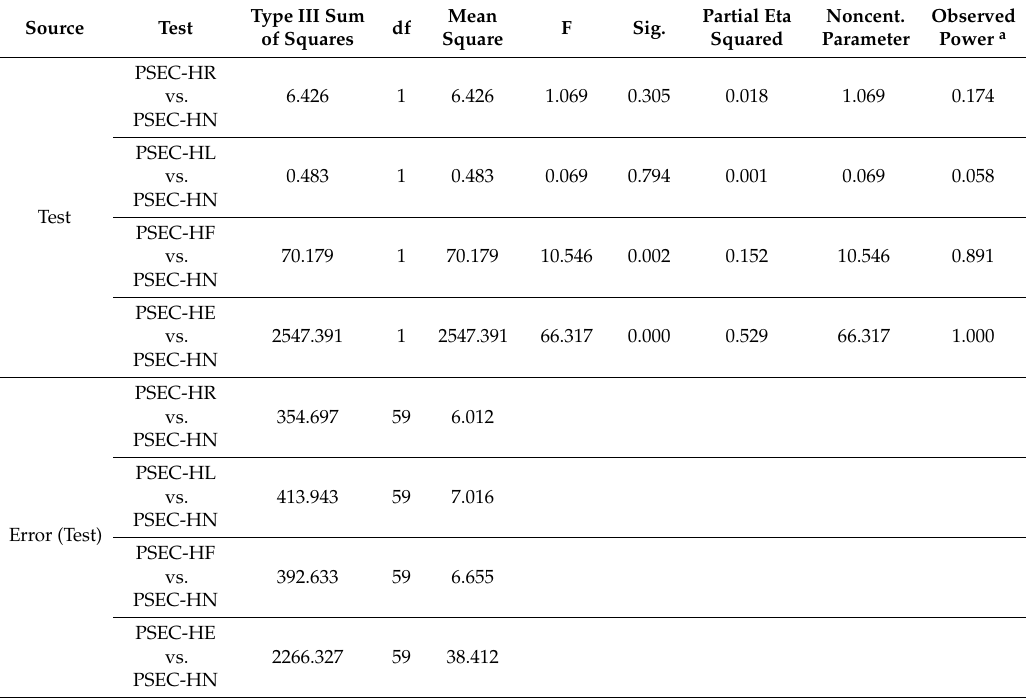
Table 9. Tests of within-Subjects Contrasts for Healthy Controls’ Postural Stability Scores with Head Rotation.